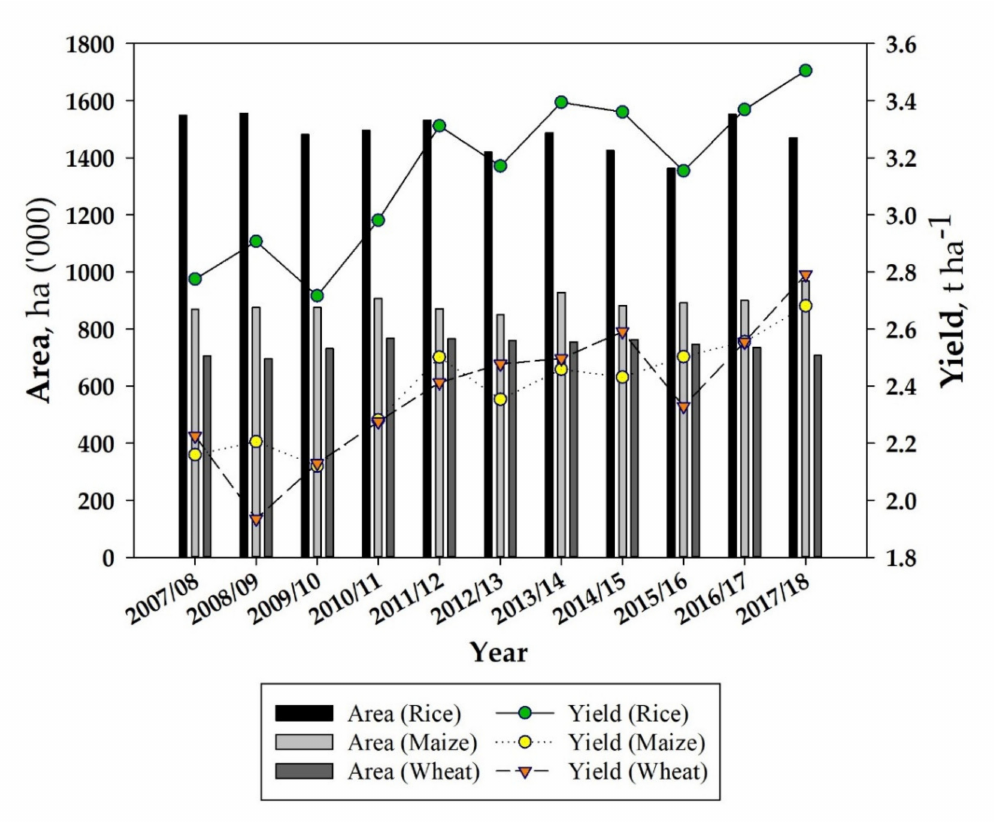
Figure 1. Trends of rice, maize, and wheat production and area covered in Nepal from 2007 / 08 to 2017 /